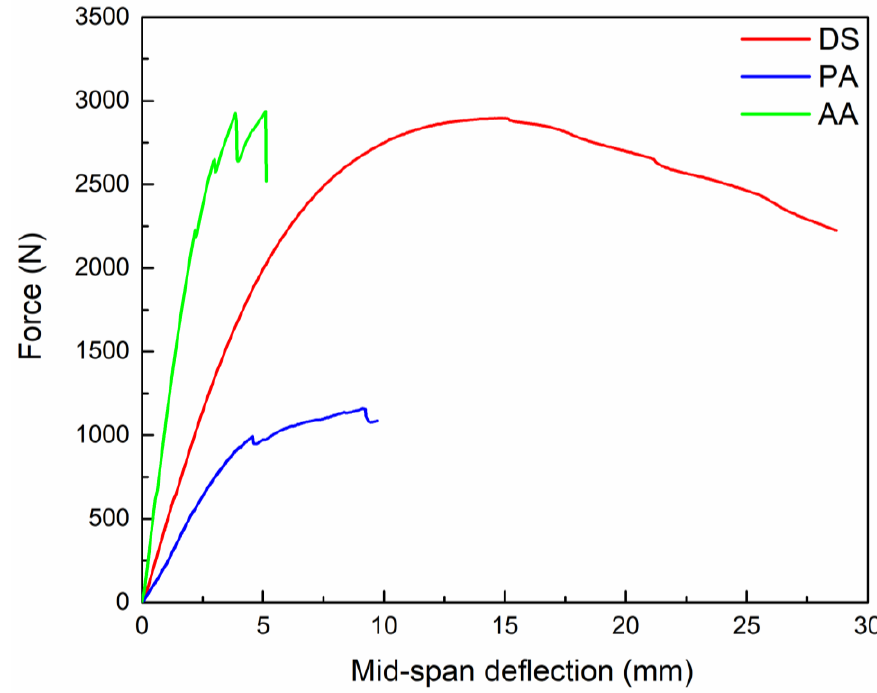
Figure 6. Bending load – displacement graphs (F b – D b ) for the three species at 6 months.